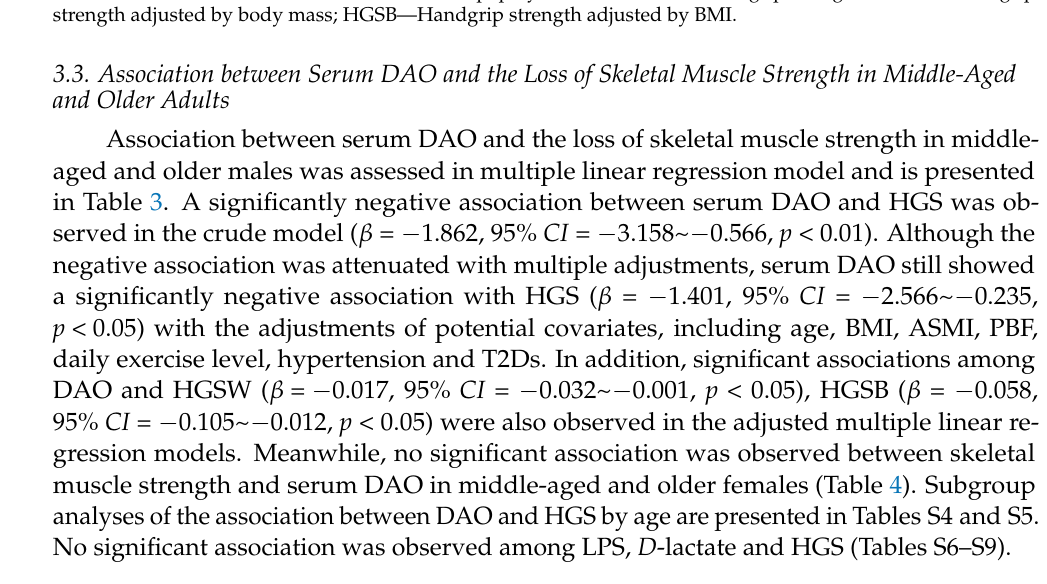
Table 3. Associations among serum DAO and skeletal muscle strength in middle-aged and older males.